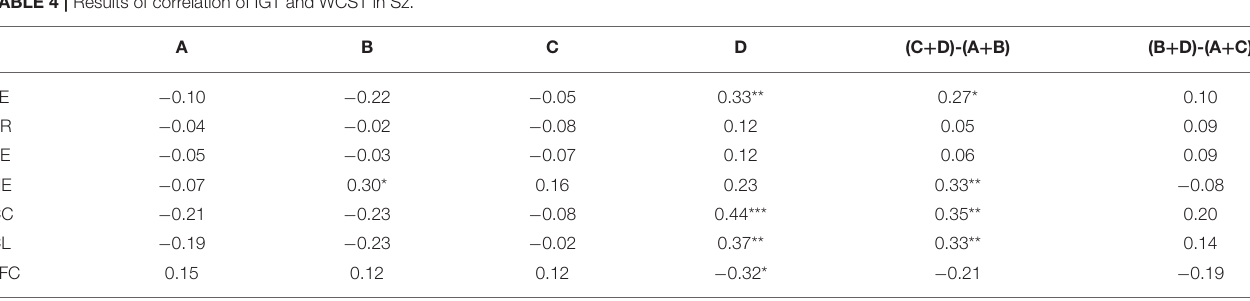
TABLE 4 | Results of correlation of IGT and WCST in